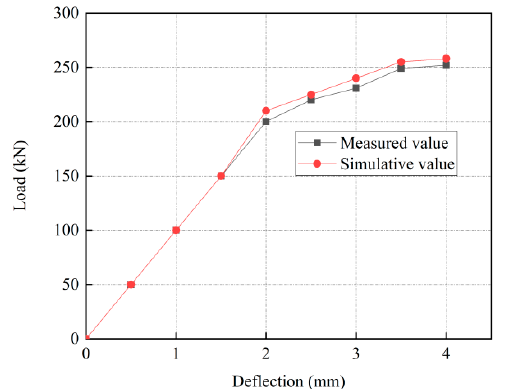
Figure 16. Comparison of measured and simulated load-displacement curves of test plate.